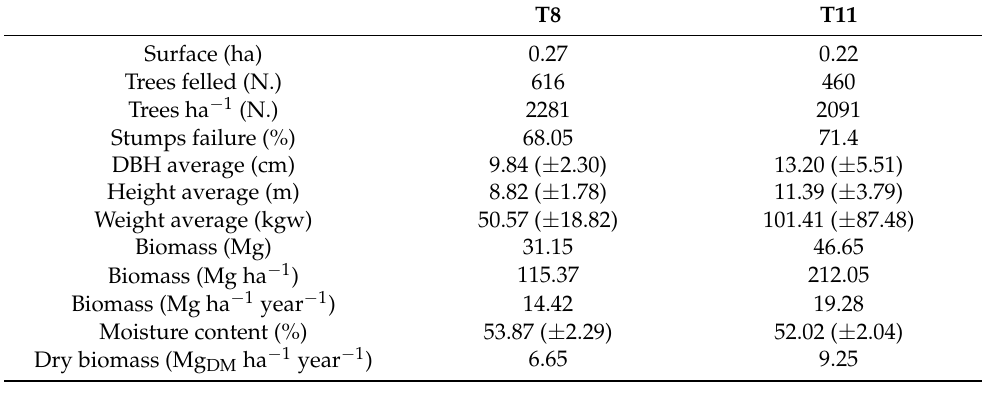
Figure 2. Box plots showing the comparison of the distributions of diameter at breast height (DBH) (cm) and height (m) in plantations T8 and T11. Table 2. Dendrometric and productive characteristics of the T8 and T11 plantations (±SD in brackets).